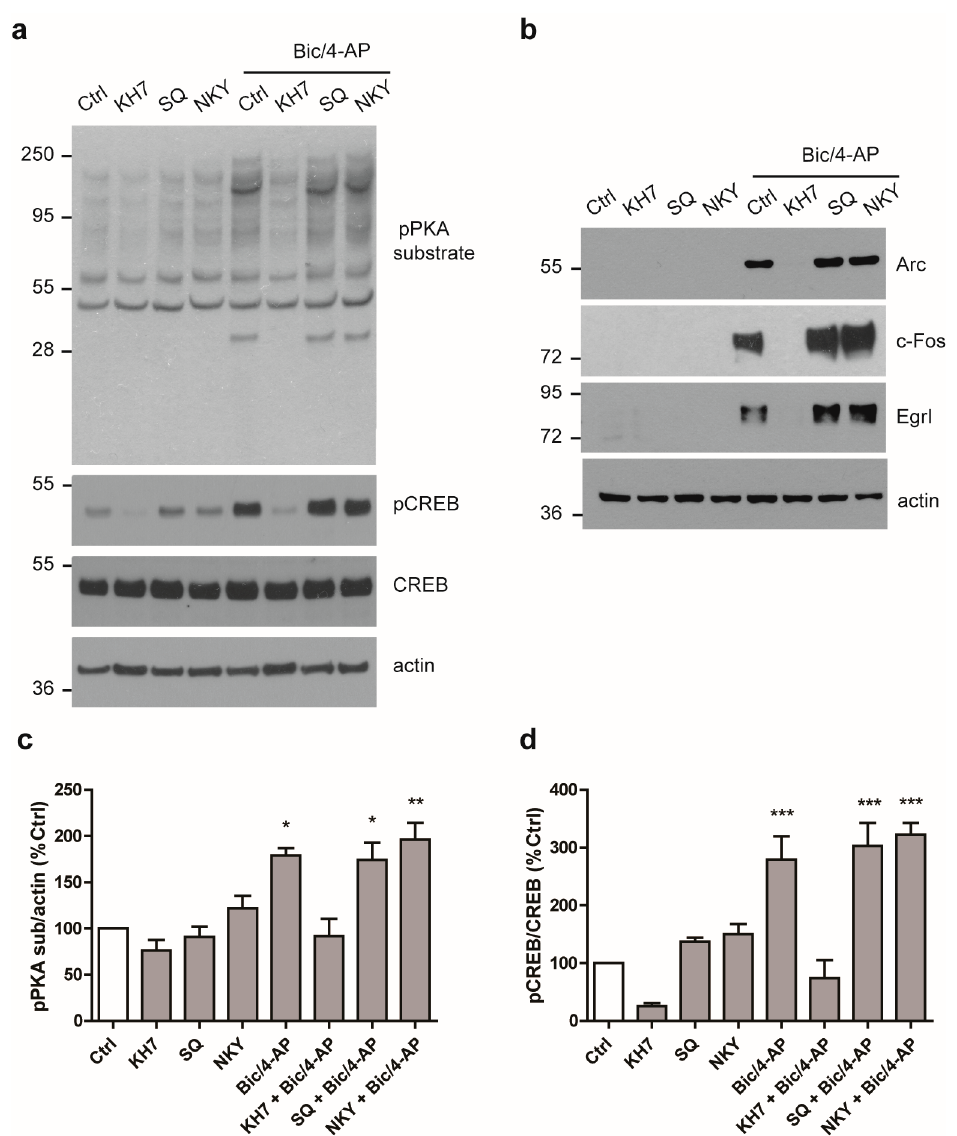
Figure 4. PKA activation following SA is dependent on soluble adenylyl cyclase (sAC). ( a ) Primary neurons at 15 DIV treated with Bic/4-AP (50µM/2.5mM, 10 min) with or without 20 min pre-treatment with the adenylyl cyclase (AC) inhibitors KH7 (20 µM), SQ22536 (SQ, 20 µM), and NKY80 (NKY, 20 µ M) were subjected to immunoblotting with anti- phospho-PKA substrate (pPKA sub), phospho-CREB (pCREB), total CREB, and actin antibodies. (Ctrl was without pre-treatment) ( b ) Quantification of WB as in (a) showing the ratios pPKA sub/actin (c) and pCREB/CREB (d) expressed as a percentage of control ( n = 4). ( c ) Primary neurons at 15 DIV treated with Bic/4-AP (2 h) with or without 20 min pre-treatment with the AC inhibitors KH7 (20 µ M), SQ (20 µ M), and NKY (20 µ M) were subjected to immunoblotting with anti- Arc, c-Fos, EgrI, and actin antibodies. Results are representative of at least four experiments. Results show mean ± SD. One-way ANOVA followed by Bonferroni’s post-hoc test were used for evaluation of statistical significance. * p < 0.05, ** p < 0.01, *** p < 0.001 .